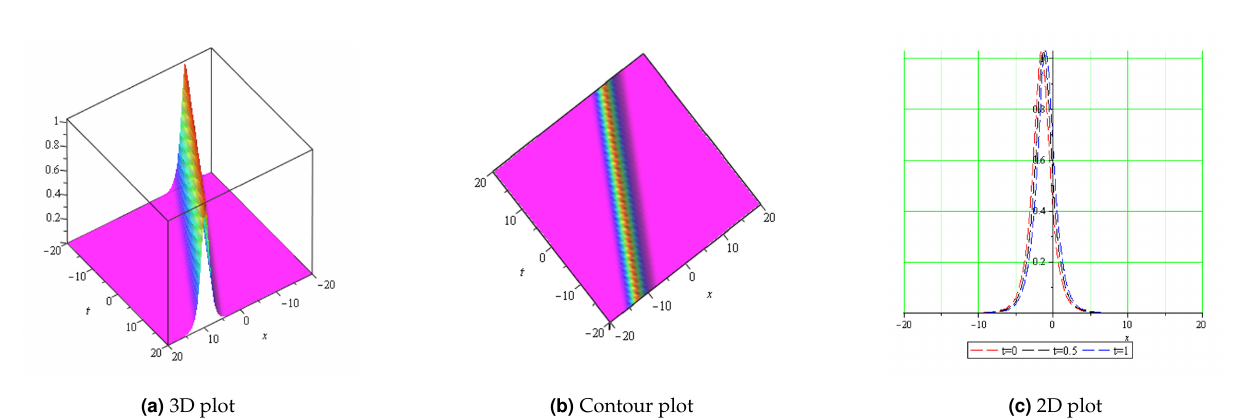
Fig. 3. The obtained the TW solution of Eq 3, when ϱ = 1, Ξ = 1.5, Π = 0.5 and y = 1, with B =